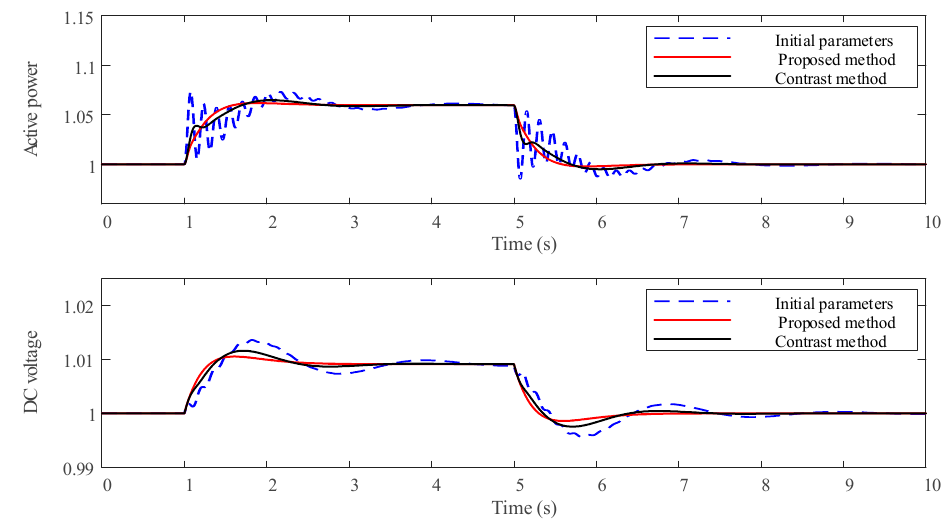
Figure 6. Active power and DC voltage of the PV-VSG with small drift at the operating point.